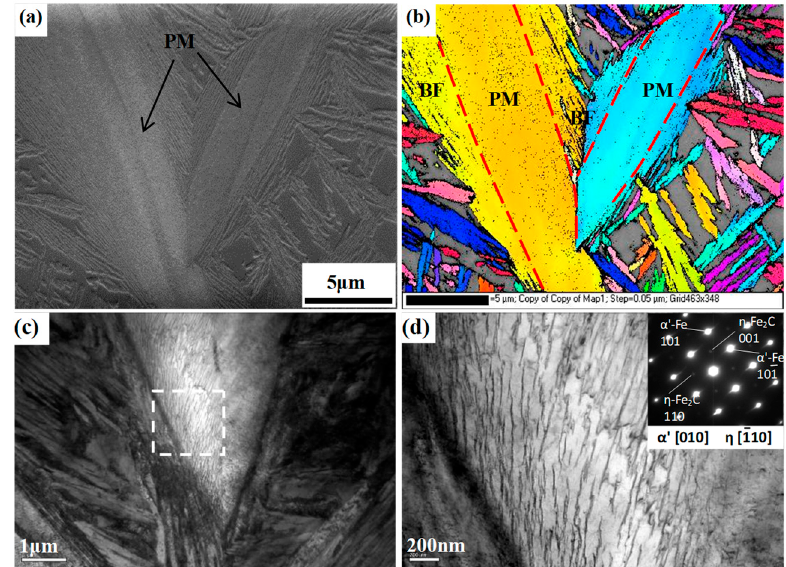
Figure 7. Microstructural characteristics of the QBT-12 sample. ( a ) SEM and the corresponding electron back-scattering diffraction (EBSD) micrograph ( b ); ( c ) TEM micrograph and ( d ) the high magnification observation of the framed area in ( c ).